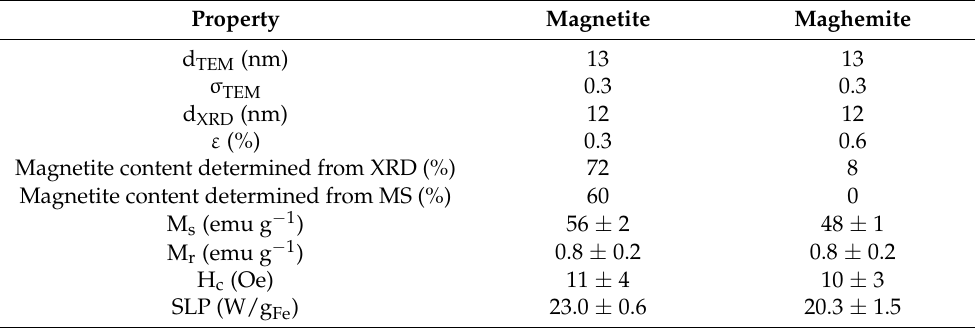
Table 1. Magnetic phase: Iron oxide NPs Structural and magnetic